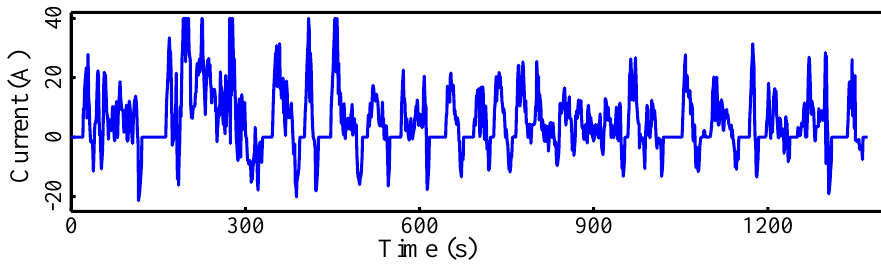
Figure 2. One cycle of FUDS profile.